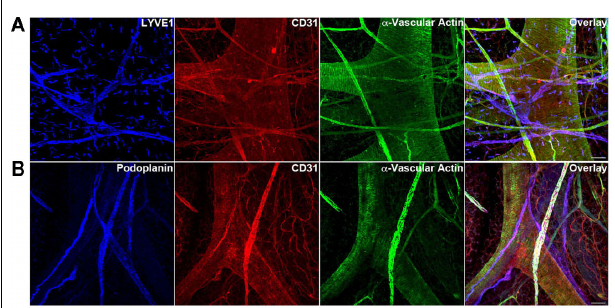
FIGURE 9 |Triple immunofluorescence staining (20 × magnification) of whole-mount mesenteric preparations of 3-month adult mice visualizing lymphatic vessels using LEC markers (A) LYVE1 (B) podoplanin and blood vessels using BEC marker CD31. Representative images from three different experiments sets for each marker genes are shown. Muscle cells are identified with α -vascular actin.The adult mouse mesentery demonstrates a complex network of blood and lymphatic vessels of different sizes. Initial lymphatic vessels (LYVE1 + /Podoplanin + ) are devoid of muscle cells ( α -vascular actin − ) whereas collecting lymphatic vessels (LYVE1 − /Podoplanin + ) show a nice arrangement of muscle cells ( α -vascular actin + ). Images were taken at 20 × magnification (scale bar 12 μ